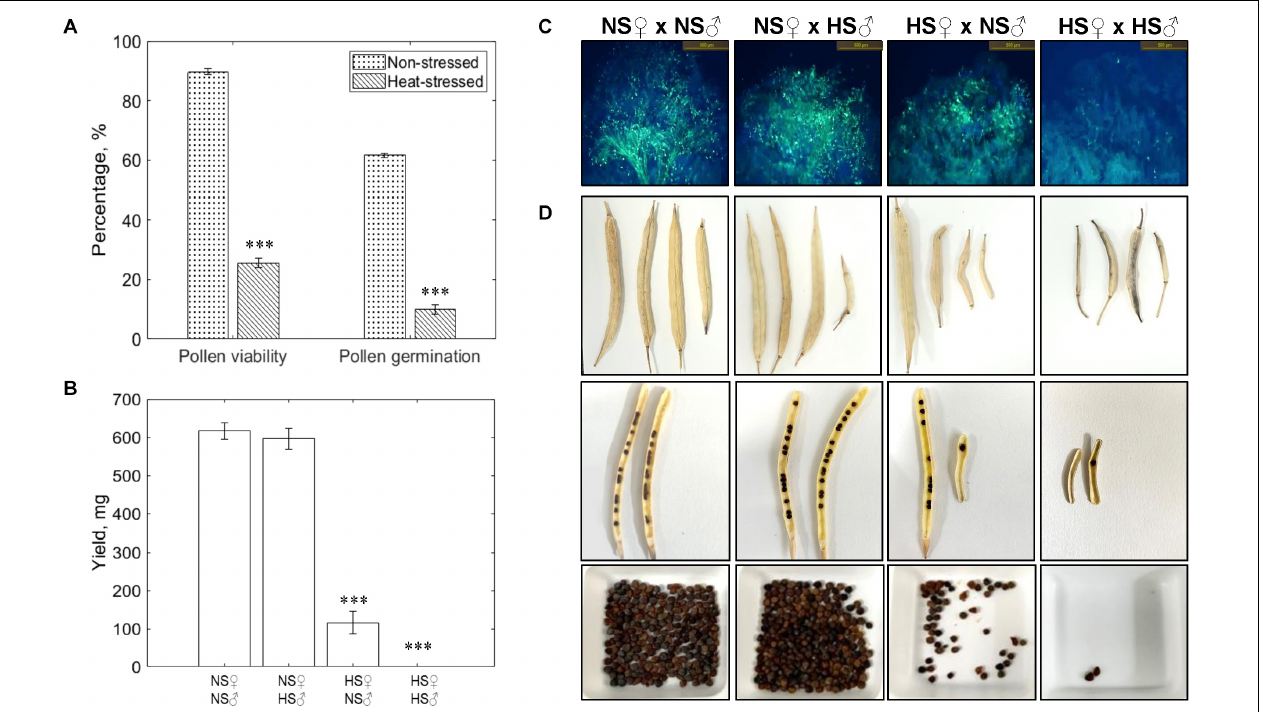
FIGURE 2 | Impact of short-term heat stress on pollen-pistil interactions. (A) Pollen viability (%) and pollen germination (%) of non-stressed, and heat-stressed (40 ◦ C for 4 h) pollen. (B) Seed yield, mg produced from the fertilization of pistils pollinated during reciprocal crosses. (C) Aniline blue staining of reciprocal crosses (NS × HS NS and HS ♀